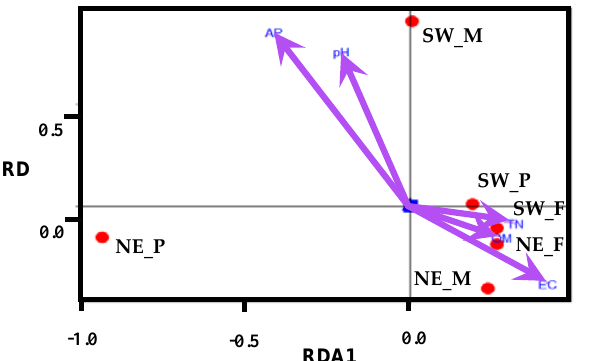
Figure 3. Redundancy analysis on the relationship between soil chemical properties and viral communities.